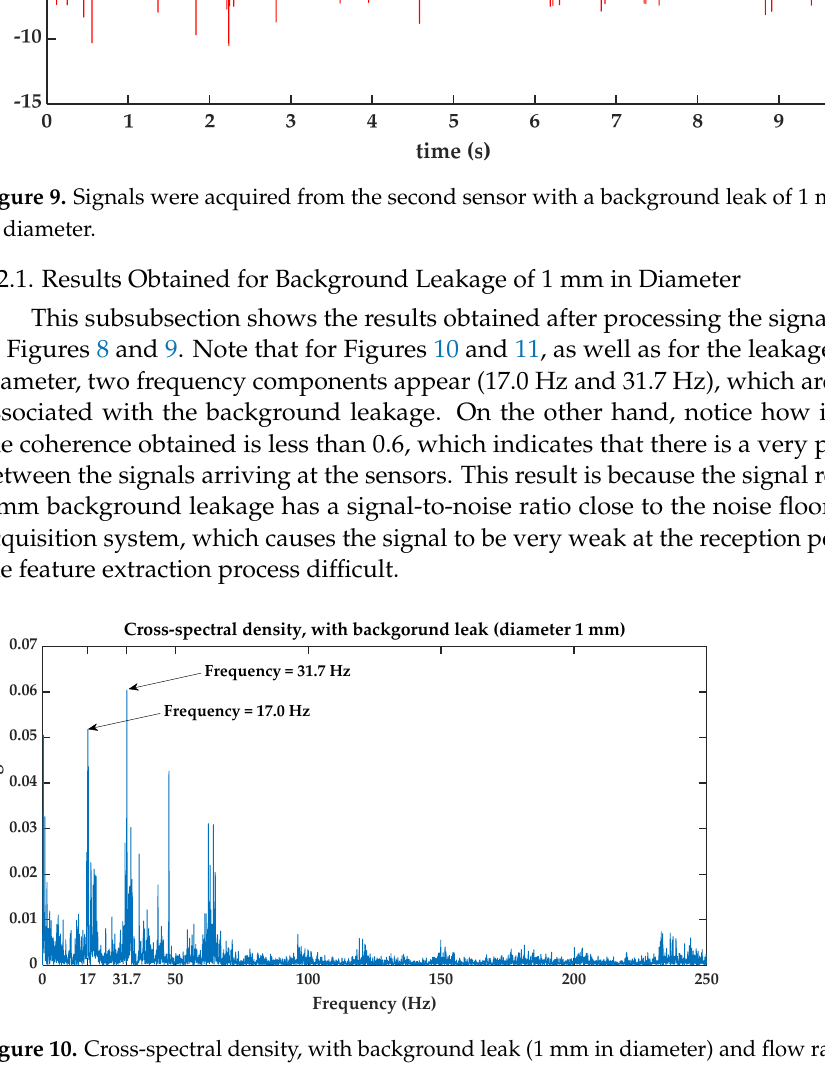
Figure 9. Signals were acquired from the second sensor with a background leak of 1 mm and 4 mm in diameter.